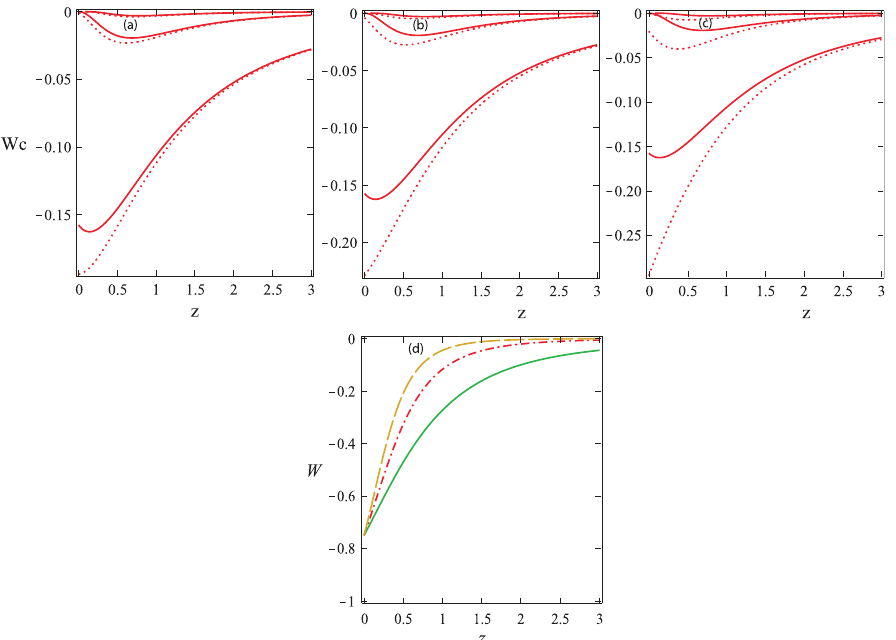
Fig. 2. Evolution of w c and w with z for gCg universes. Panels (a–c): from left to right, the values of α are 1, 0.5, 0. The solid line represents δ b without the effect of the additive term σ 2 − ω 2 , whereas the dotted line is shown with its presence. The value of β is 0.01 in panel (a), 0.02 in panel (b), and 0.04 in panel (c). Panel (d): w versus z for α = 1 (dashed line), 0.5 (dot-dashed line), 0 (solid